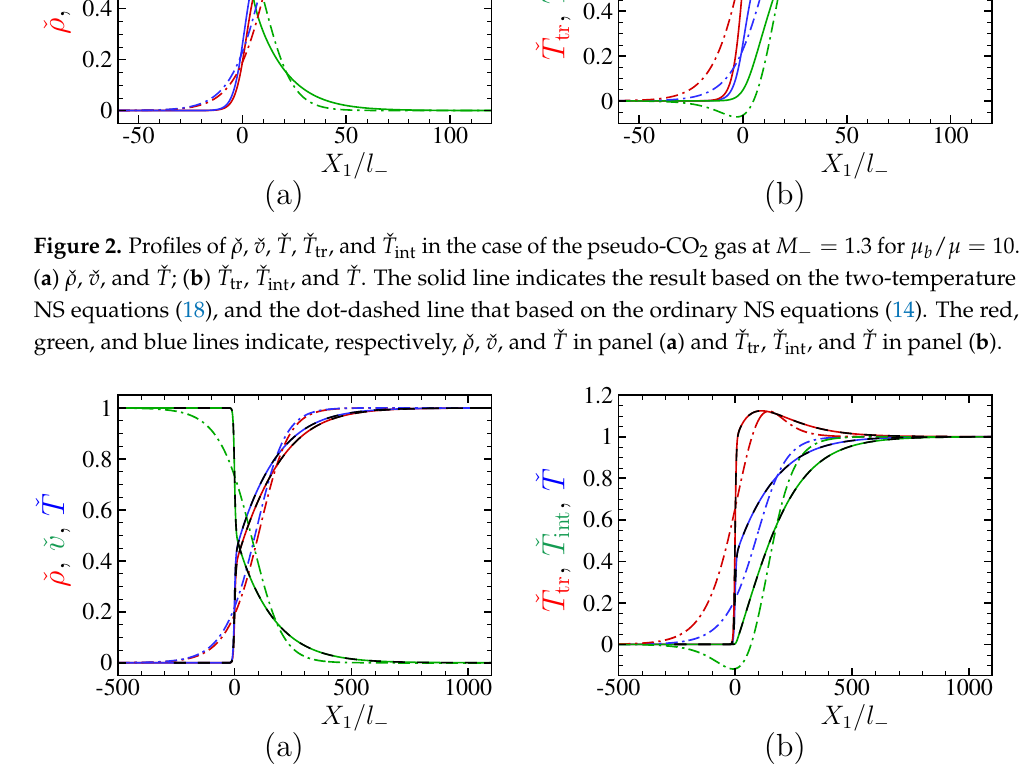
Figure 3. Profiles of ˇ ρ , ˇ v , ˇ T , ˇ T tr , and ˇ T int in the case of the pseudo-CO 2 gas at M − = 1.3 for µ b / µ = 100. ( a ) ˇ ρ , ˇ v , and ˇ T ; ( b ) ˇ T tr , ˇ T int , and ˇ T . The solid line indicates the result based on the two-temperature NS equations (18), and the dot-dashed line that based on the ordinary NS equations (14). The red, green, and blue lines indicate, respectively, ˇ ρ , ˇ v , and ˇ T in panel ( a ) and ˇ T tr , ˇ T int , and ˇ T in panel ( b ). The profiles based on the ES model (2) are shown by the black dashed line for all